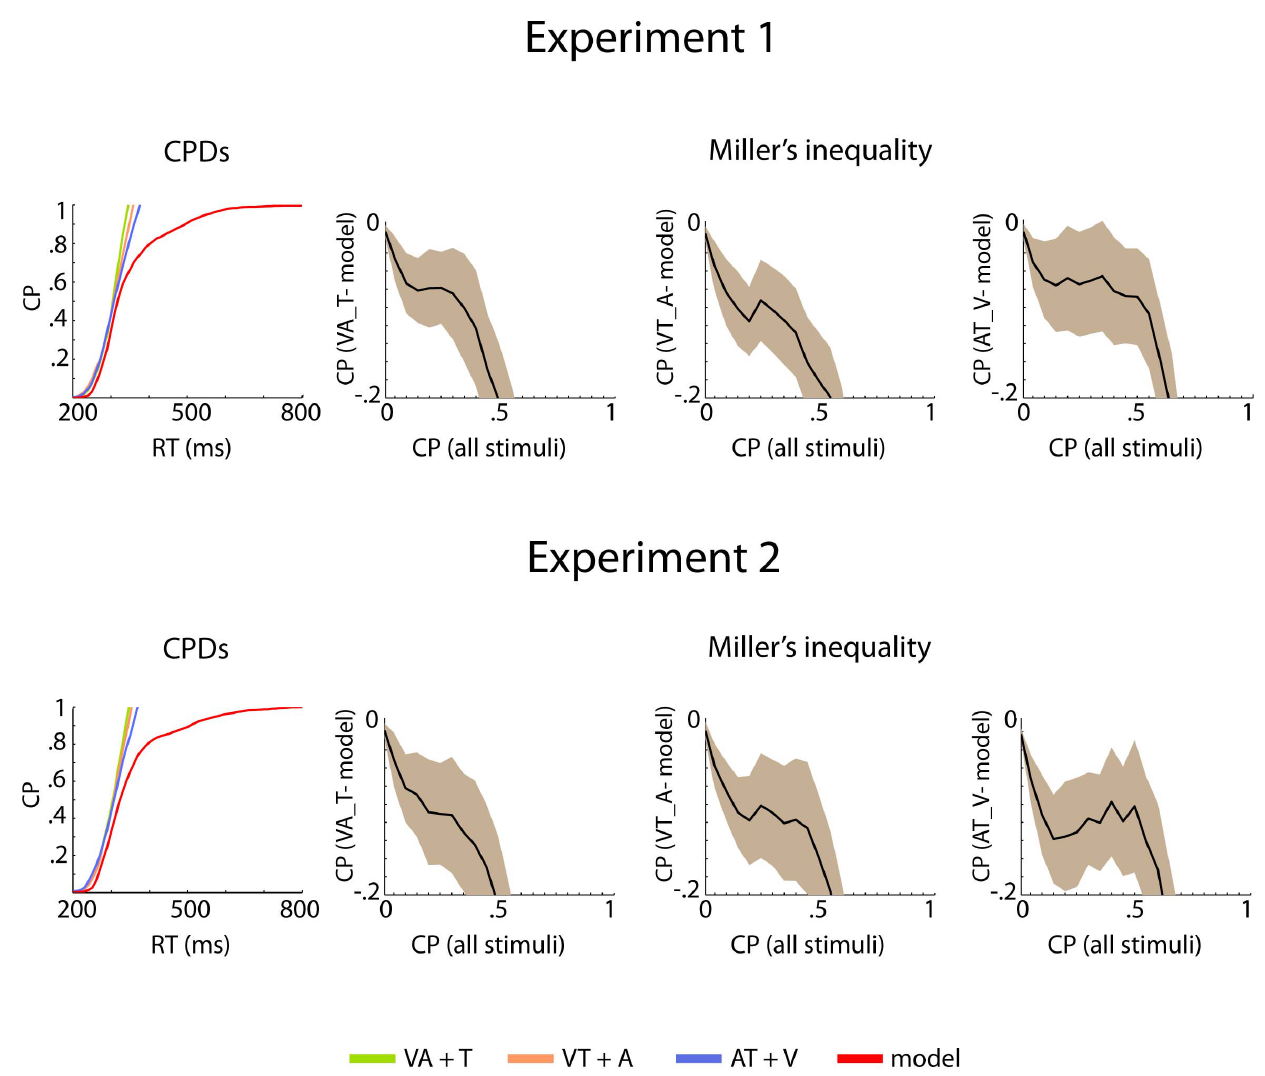
Figure 4. Cumulative probability distributions and Miller’s inequality for bisensory and trisensory stimuli. The comparison of bisensory vs. trisensory stimuli did not reveal significant race model violations.